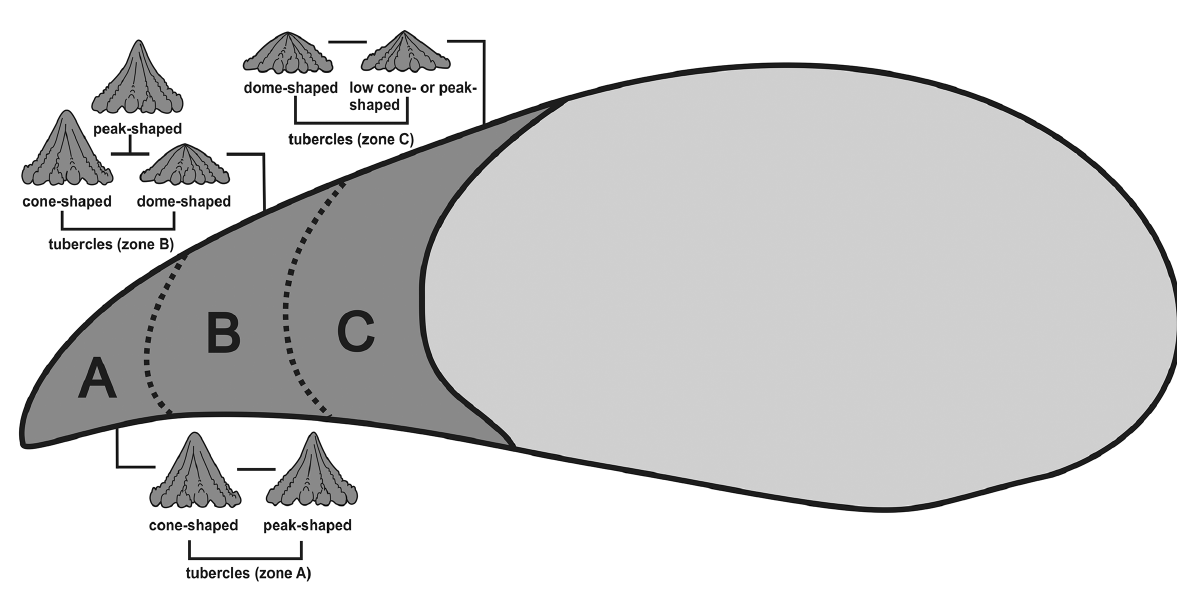
Fig. 5. Location of topographical zones of tubercles on branchial plate of P. livonicus : A, distal; B, median; C, proximal.